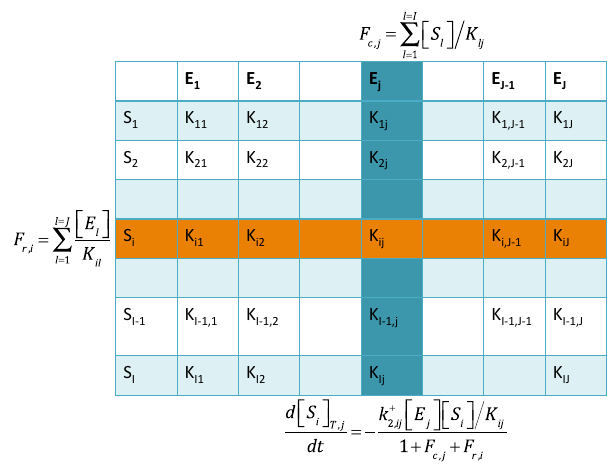
Figure 1. Graphical representation of ECA kinetics as derived in Tang and Riley (2013a). The equation below the table shows the uptake of substrate S i by consumer E j as a function the normal- ized substrate flux F c ,j and its conjugate flux F r ,i . Subscript “c” designates column, and “r” designates row. When K ij is very large compared to other entries in the matrix, the interaction between sub- strate S i and consumer E j can be